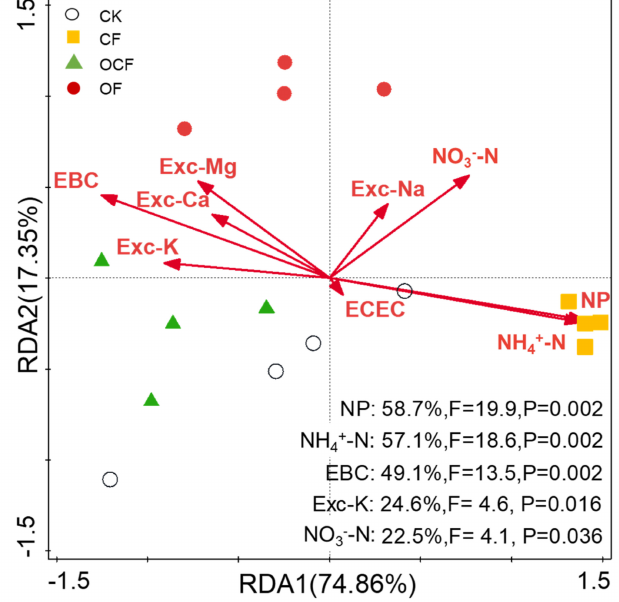
Figure 4. Redundancy analysis of soil acidification index and soil ions in tobacco planting brown soil. CK, no fertilization; CF, single application of chemical fertilizer; OCF, application of organic- inorganic fertilizer; OF, single application of organic fertilizer. EBC, total exchangeable base content; Exc-K, exchangeable potassium; Exc-Mg, exchangeable magnesium; Exc-Ca, exchangeable calcium; Exc-Na, exchangeable sodium; ECEC, effective cation exchange capacity; Exc-Aci, exchangeable acid; Exc-H, exchangeable hydrogen; Exc-Al, exchangeable aluminum; Al-Sat, Al saturation; Ec, electric